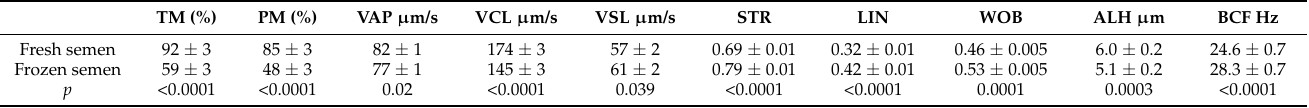
Table 3. Sperm kinematics (LSMeans ± sem) for fresh and frozen buck semen ( n =